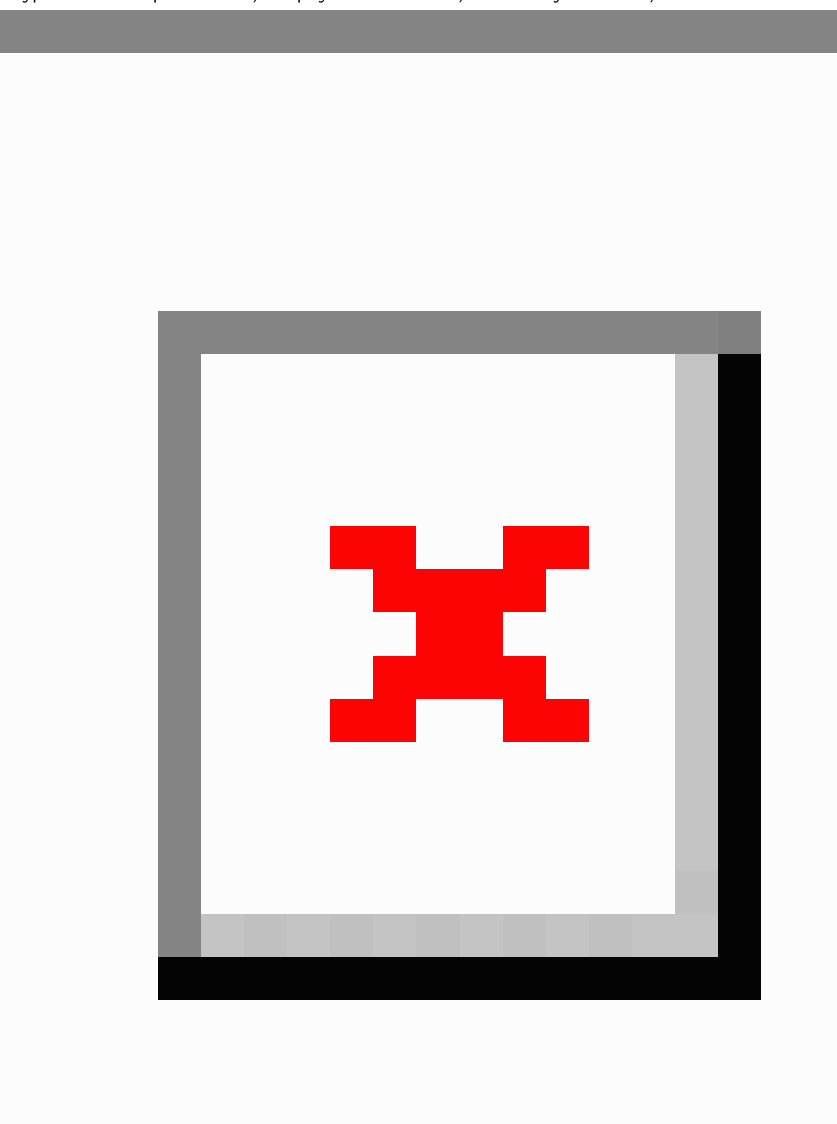
Figure 2. Bubble chart of percentage of photo sessions with dermatology input (via eConsult, curbside consult, and/or in person dermatology visit)